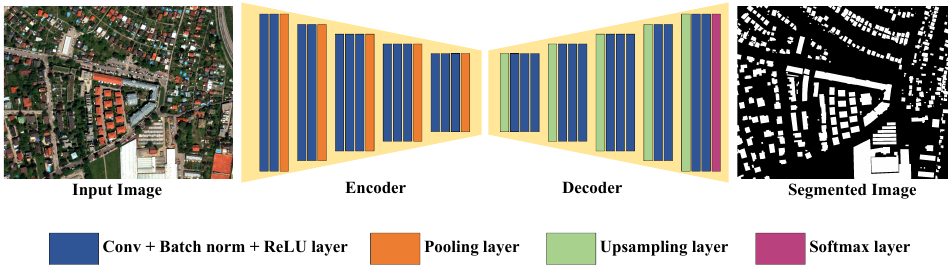
Figure 2. The encoder–decoder network architecture of SegNet.